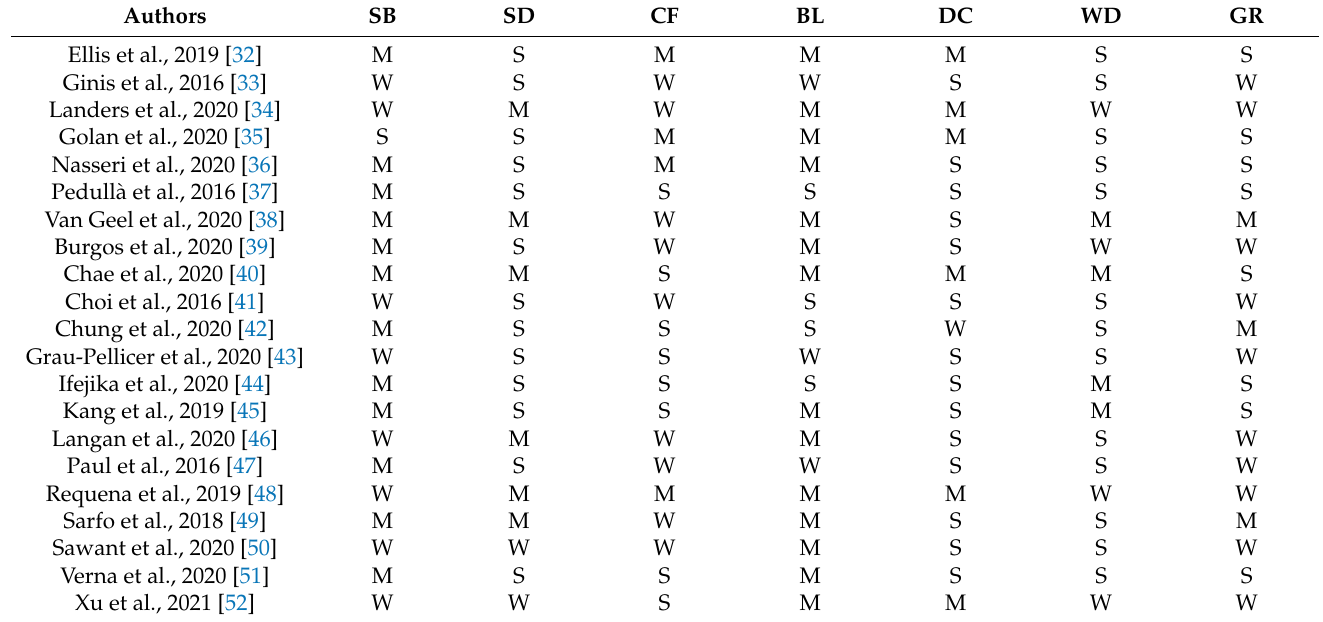
Table 1. Quality assessment of studies based on the EPHPP criteria (studies sorted by disease alphabetically, SB: Selection Bias, SD: Study Design, CF: Confounders, BL: Blinding, DC: Data Collection, WD: Withdrawals and Dropouts, GR: EPHPP Global Rating, W: Weak, M: Moderate, S: Strong).